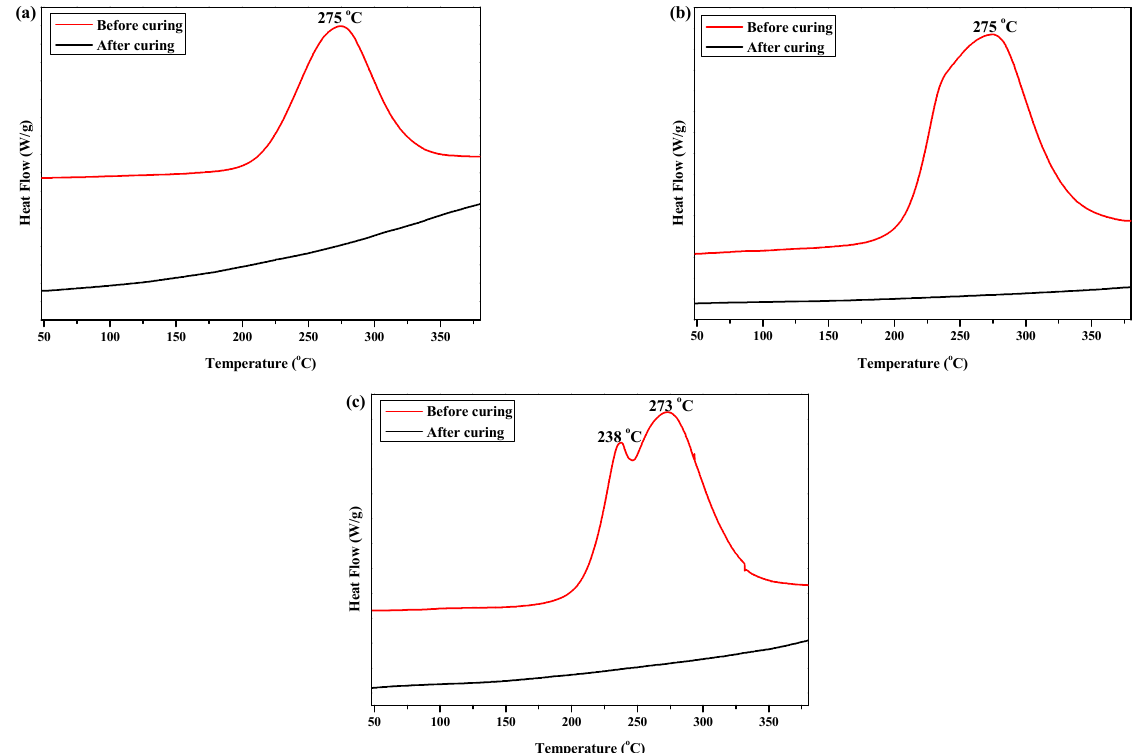
Figure 1. The DSC curves of ( a ) P(4-MB-co-1-MP), ( b ) P(4-MB-co-1-MP)/BCB-POSS, and ( c ) P(4-MB-co-1-MP)/DVS-BCB before and after curing.